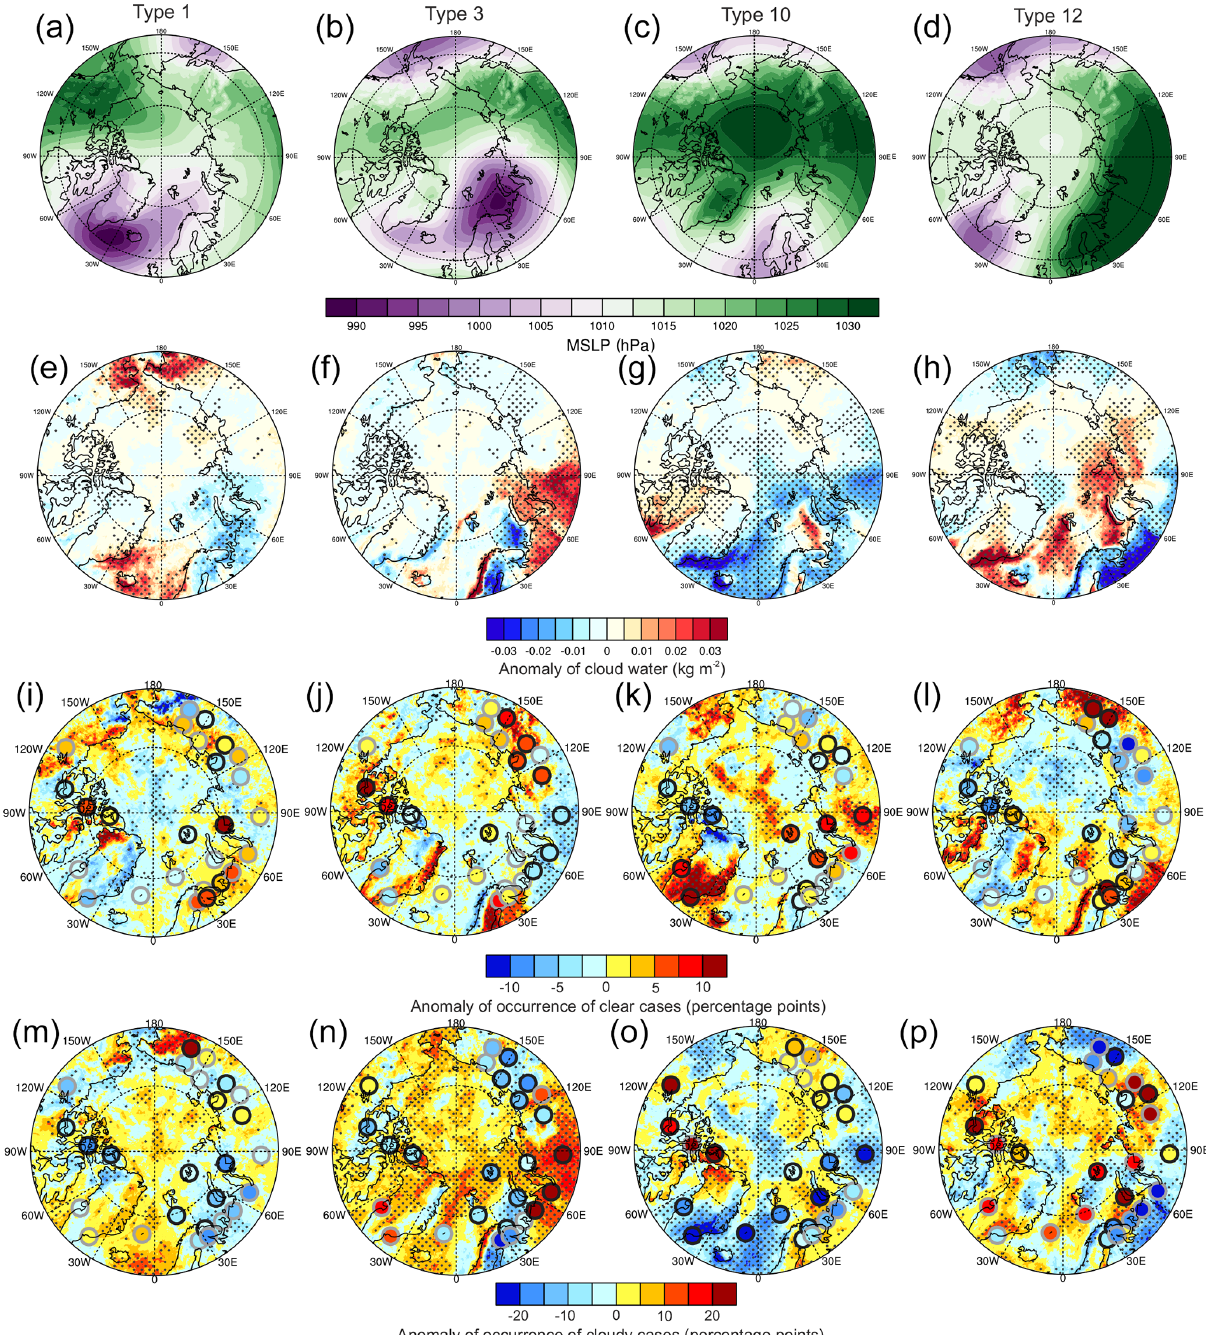
Figure 3. Mean sea level pressure (a–d) , anomaly of total column (liquid and frozen) cloud water (e–h) , anomaly of occurrence of clear skies (cloud fraction ≤ 1 / 8) (i–l) and occurrence of overcast conditions (cloud fraction ≥ 7 / 8) (m–p) in four SOM circulation types (indicated on the top of the column) during December–February 2009–2018. The colours inside the circles in (i) – (p) show synoptic cloud observations at the radiosounding stations, whereas the fields in (a) – (p) are based on ERA5. The dotted shadings (ERA5) and black circles (synoptic cloud observations) show the anomalies that are different from zero at the 99% significance